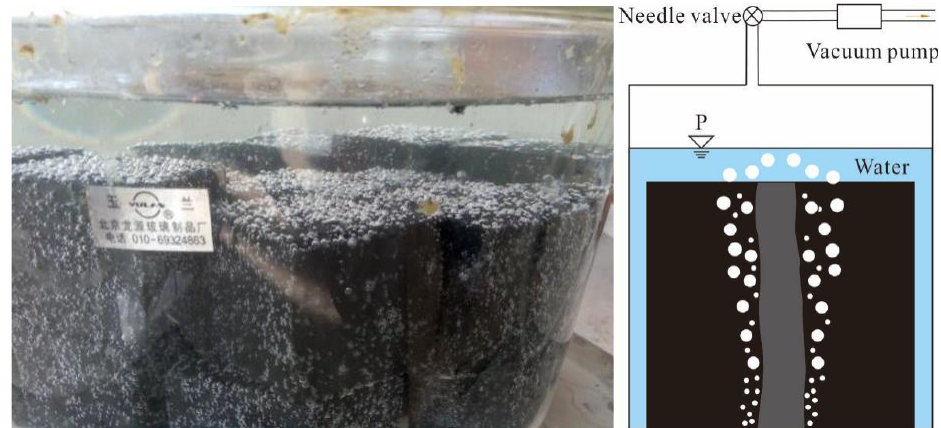
Figure 18. Effusion of CH 4 during forced water adsorption of lump coal and its interpretation.